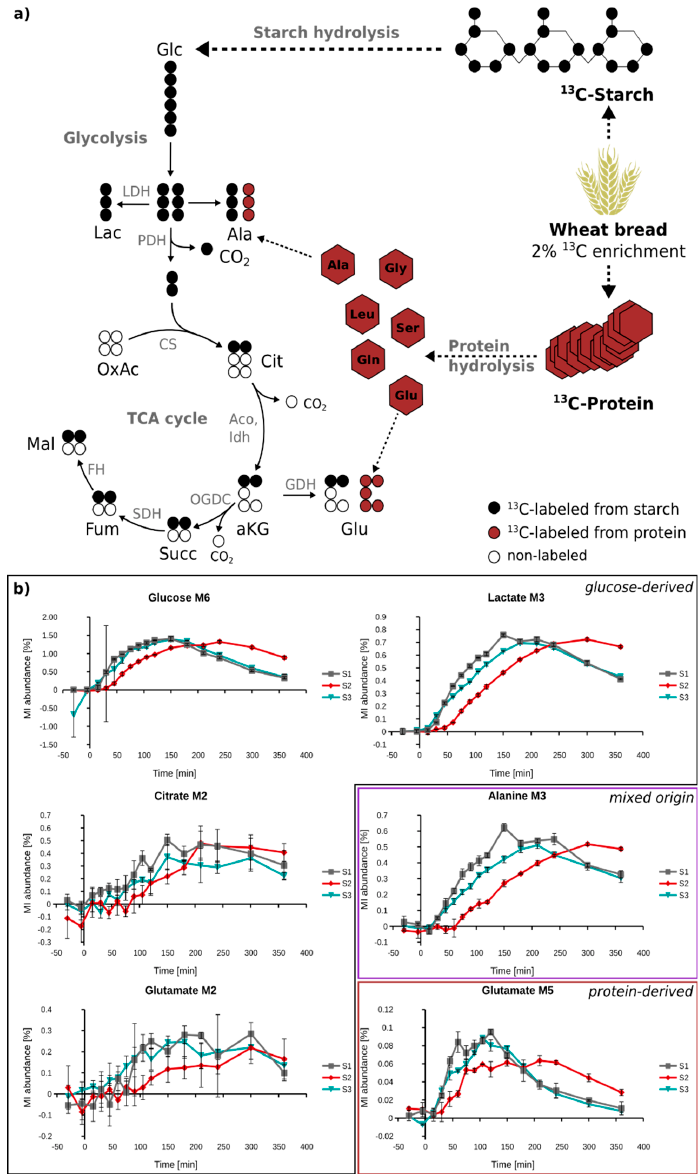
Figure 5. Validation of MID calculation of ultra-low 13 C enriched plasma metabolites of subject 1 (S1), subject 2 (S2), and subject 3 (S3)—( a ) Wheat bread with 2% of 13 C-labeled wheat flour is composed of